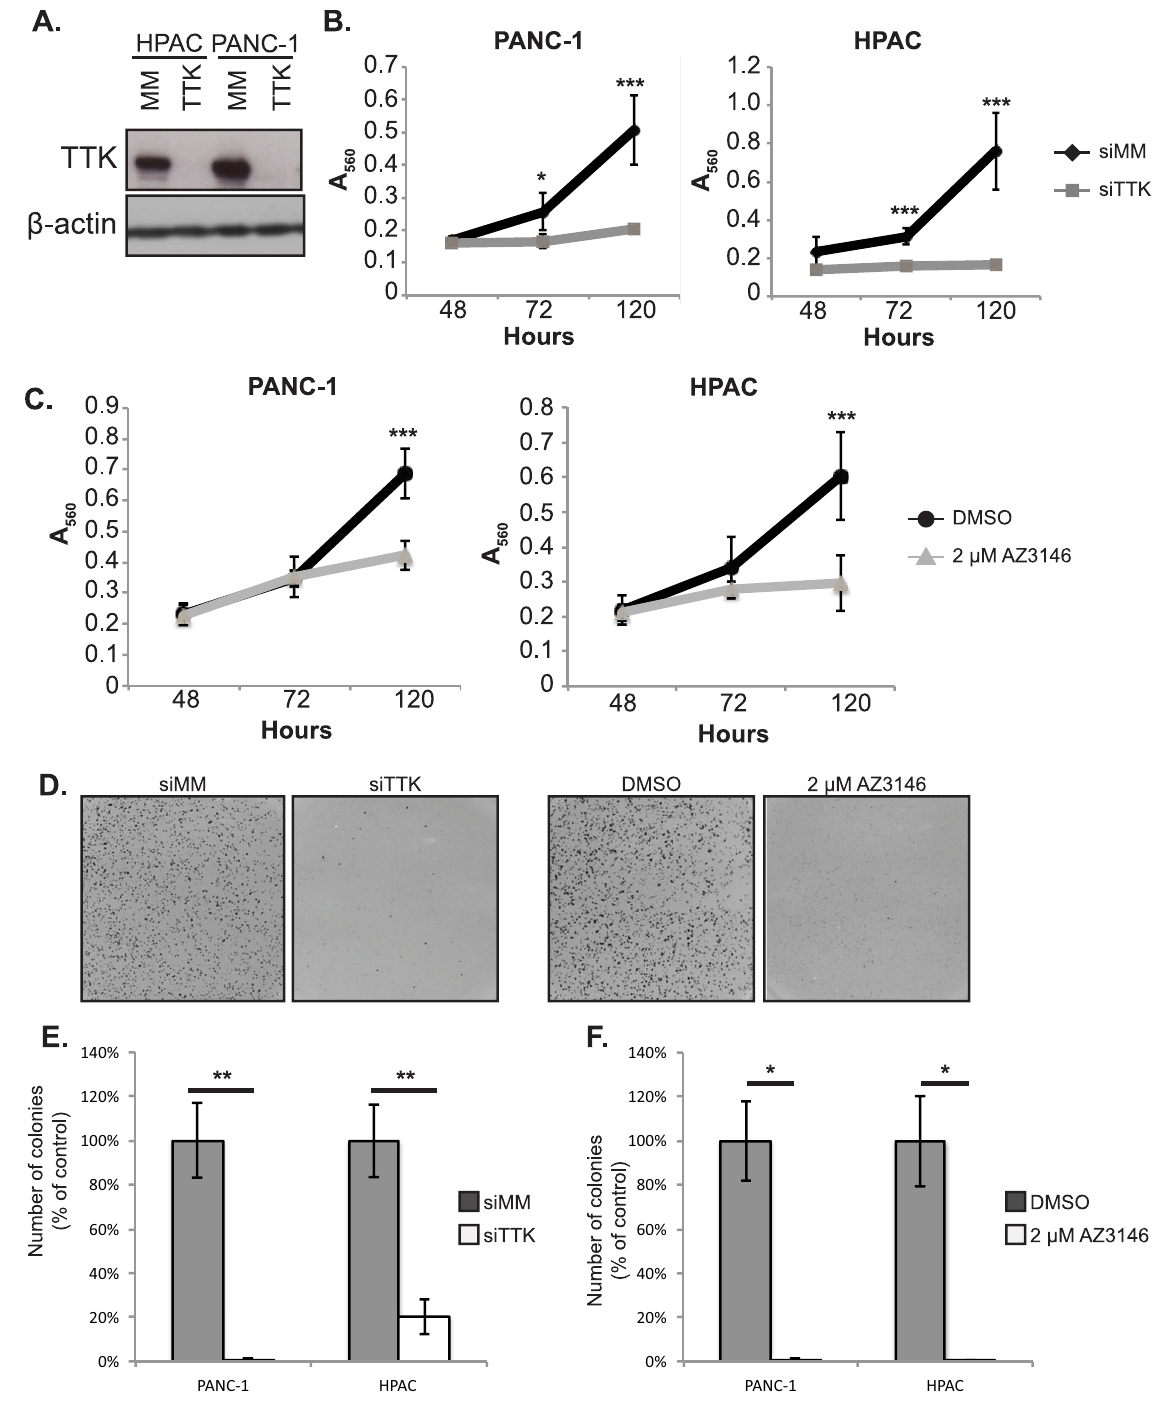
Fig 3. Genetic and pharmacologic inhibition of TTK decreasegrowth of PDAC cell lines. (A) Immunoblotanalysisof HPAC and PANC-1 cell extracts showingprotein level of TTK in control mismatch siRNA (siMM) and a TTK siRNA (siTTK) pool 48 h after transfection. (B) Growth of HPAC and PANC-1 PDAC cell lines transfected with control siMM and siTTK show reducedviability with TTK depletion.Cells were measuredfor proliferation at 48, 72, and 120 h as indicated. (C) Growth of HPAC and PANC-1 PDAC cell lines treated with DMSO control or 2 μ M AZ3146. Cells were measuredfor proliferationat 48, 72, and 120 h as indicated.(D) Representative images of colony formation of the PANC-1 cell line in soft agar. (E) Quantitationof colony formation in soft agar of the HPAC and PANC-1 cell lines after transfectionof either control or TTK targeted siRNA. Samplesnormalizedto control.